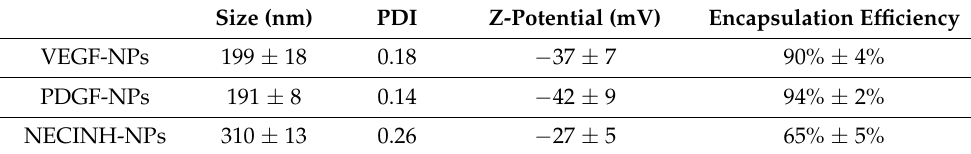
Table 1. Physicochemical characteristics of the NPs.